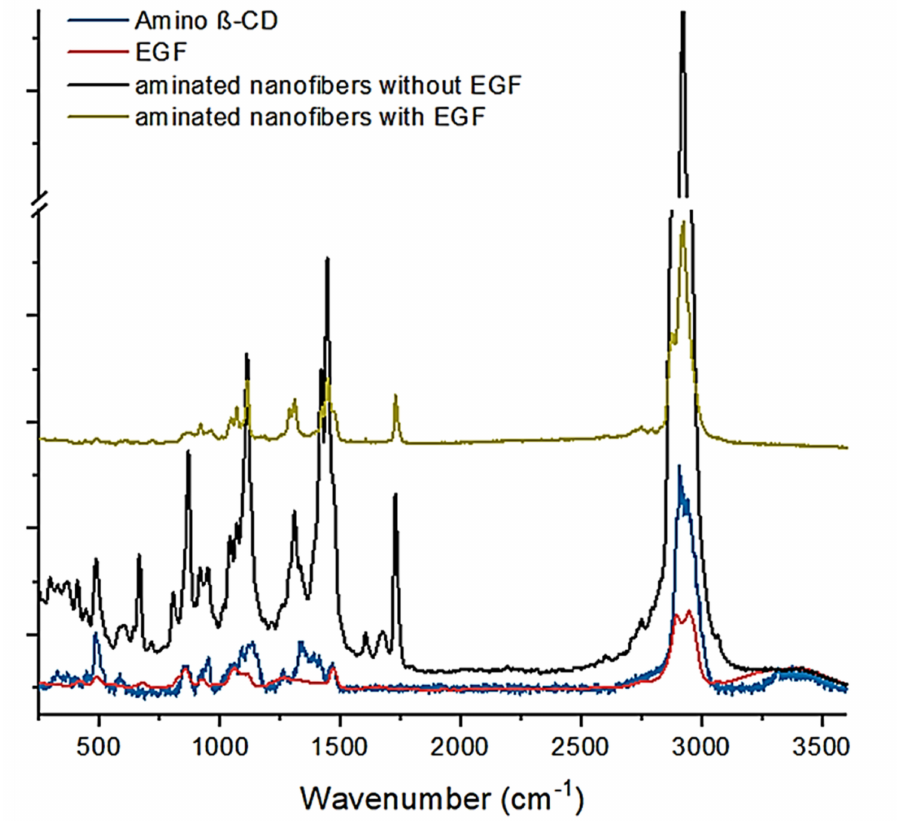
Figure 2. Raman spectra of started materials and the nanofibers with and without